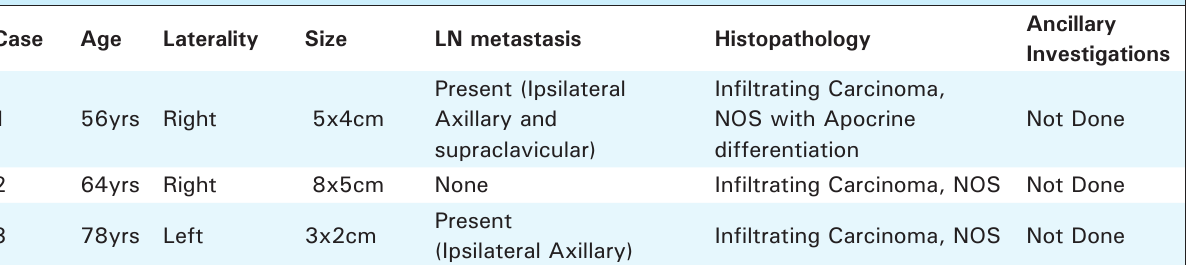
Table 1. Salient features of all 3 cases of